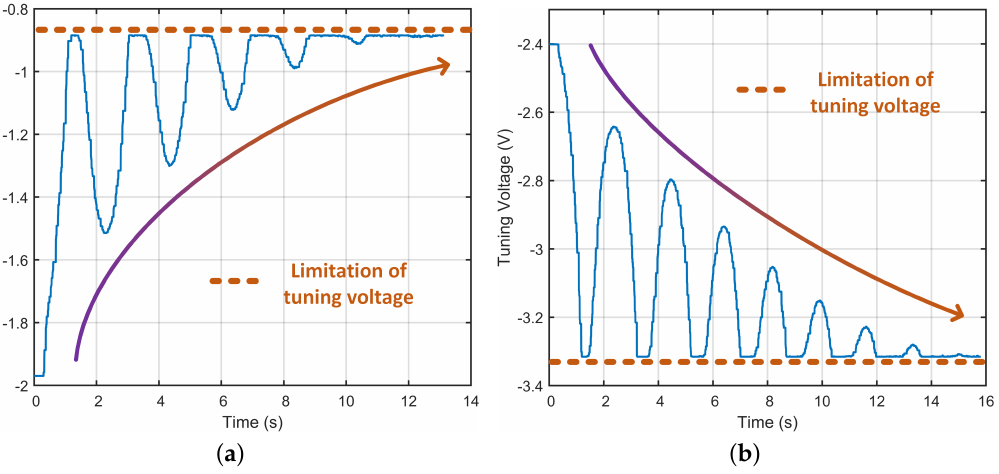
Figure 10. Reverse auto-adjustment of tuning voltage in unstable region. ( a ) Change of tuning voltage when the initial frequency split is greater than 40 mHz. ( b ) Change of tuning voltage when the initial frequency split is greater than − 40